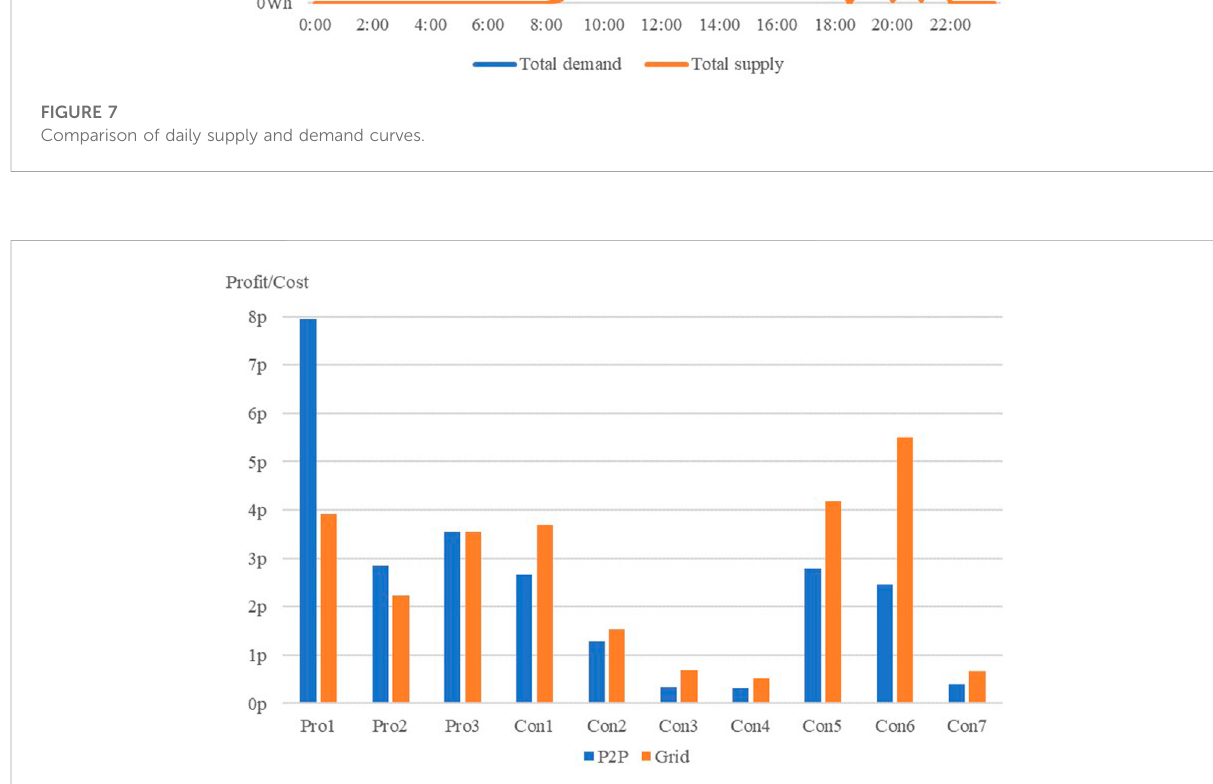
FIGURE 8 User energy costs (SDR >